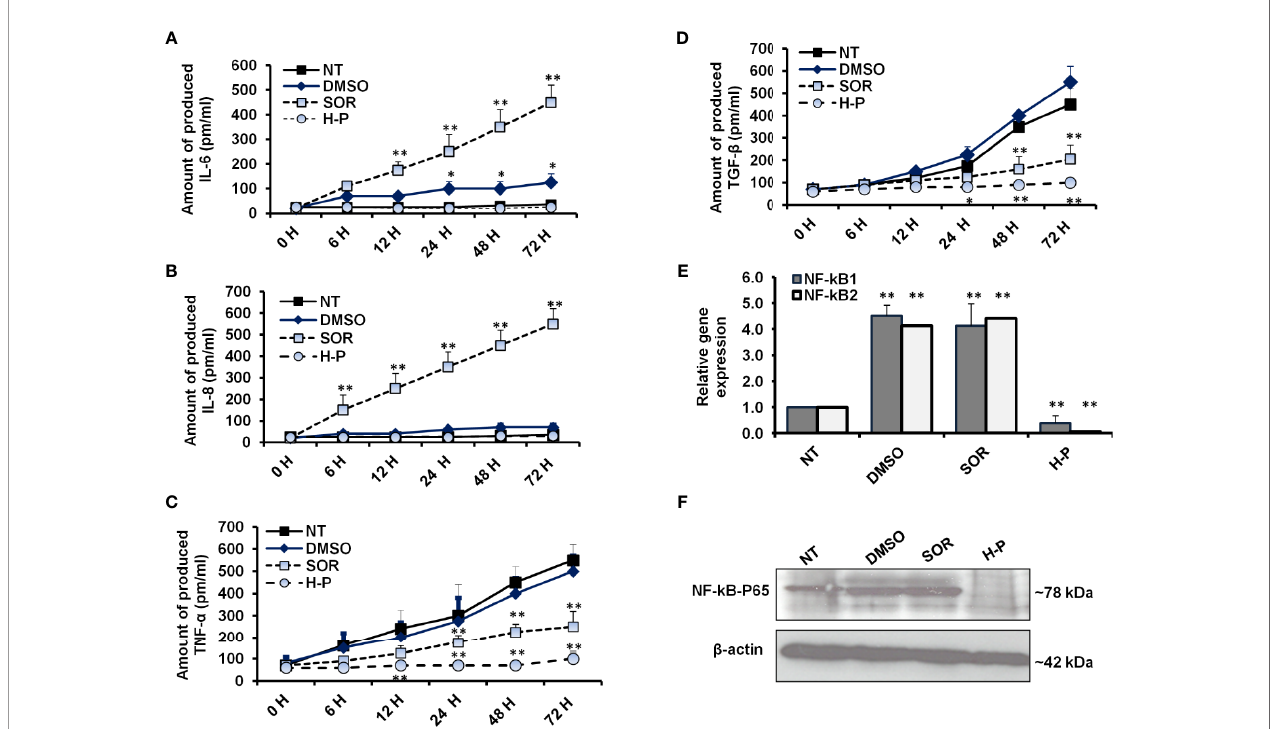
FIGURE 3 | Levels of proin fl ammatory cytokines and NF-kB effectors in treated-cells. (A, B) The concentration of produced IL-6 and IL-8 (pm/ml) in the fl uids media of MCF-7 cells that were subjected to 800 µg/ml of either SOR or H-P extract for the indicated time points compared with DMSO-treated cells, n = 4. (C, D) Level of produced TNF- a and TGF- b (pm/ml) in the fl uid media of MCF-7 cells that were subjected to 800 µg/ml of either SOR or H-P extract for the indicated time points compared with DMSO-treated cells, n = 4. Error bars reveal the SD of four biological replicates. (E) Relative gene expression of NF-kB1 and NF-kB2 in treated cells compared with DMSO-treated cells that are quanti fi ed by qRT-PCR. Error bars reveal the SD of three independent experiments. (F) Immunoblotting analysis of the conjugated NF-kB – P65 in treated MCF-7 cells using WesternBreeze Chromogenic Kit. b -Actin served as a loading control. Data are representative of three independent experiments. A Student ’ s t-test analysis was performed. * p < 0.05, ** p <